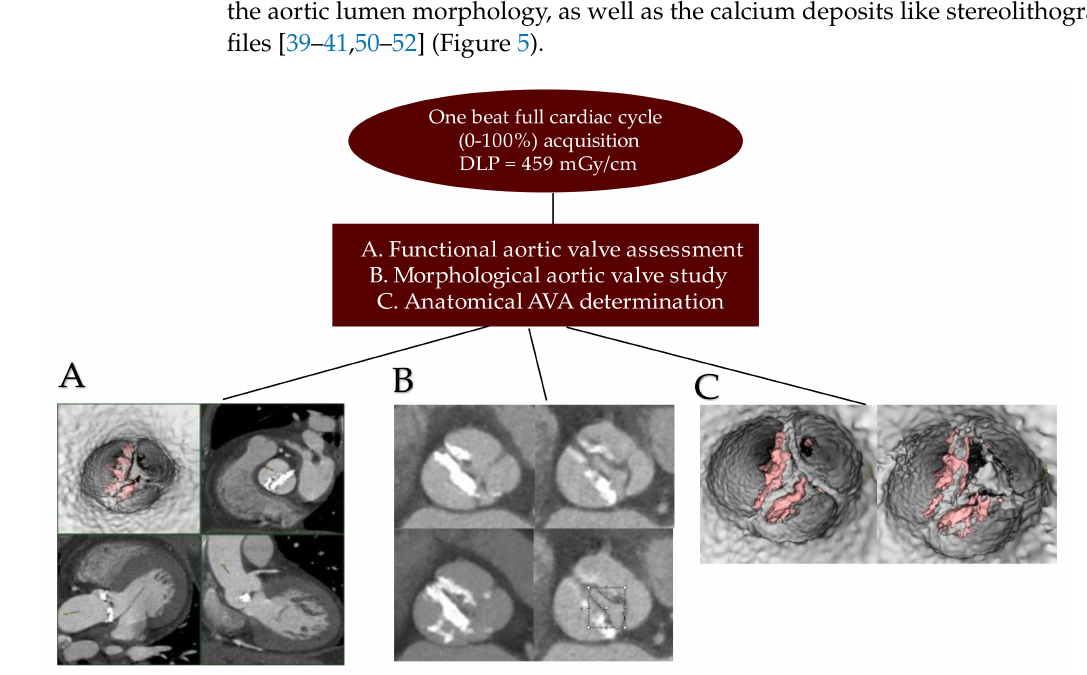
Figure 4. DICOM from a 3D CT scan serves to extract the RAW data that allow definition of functional aortic valve assessment ( A ), morphological aortic valve features ( B ), and anatomical aortic valve characteristics ( C ); abbreviations in other figures.